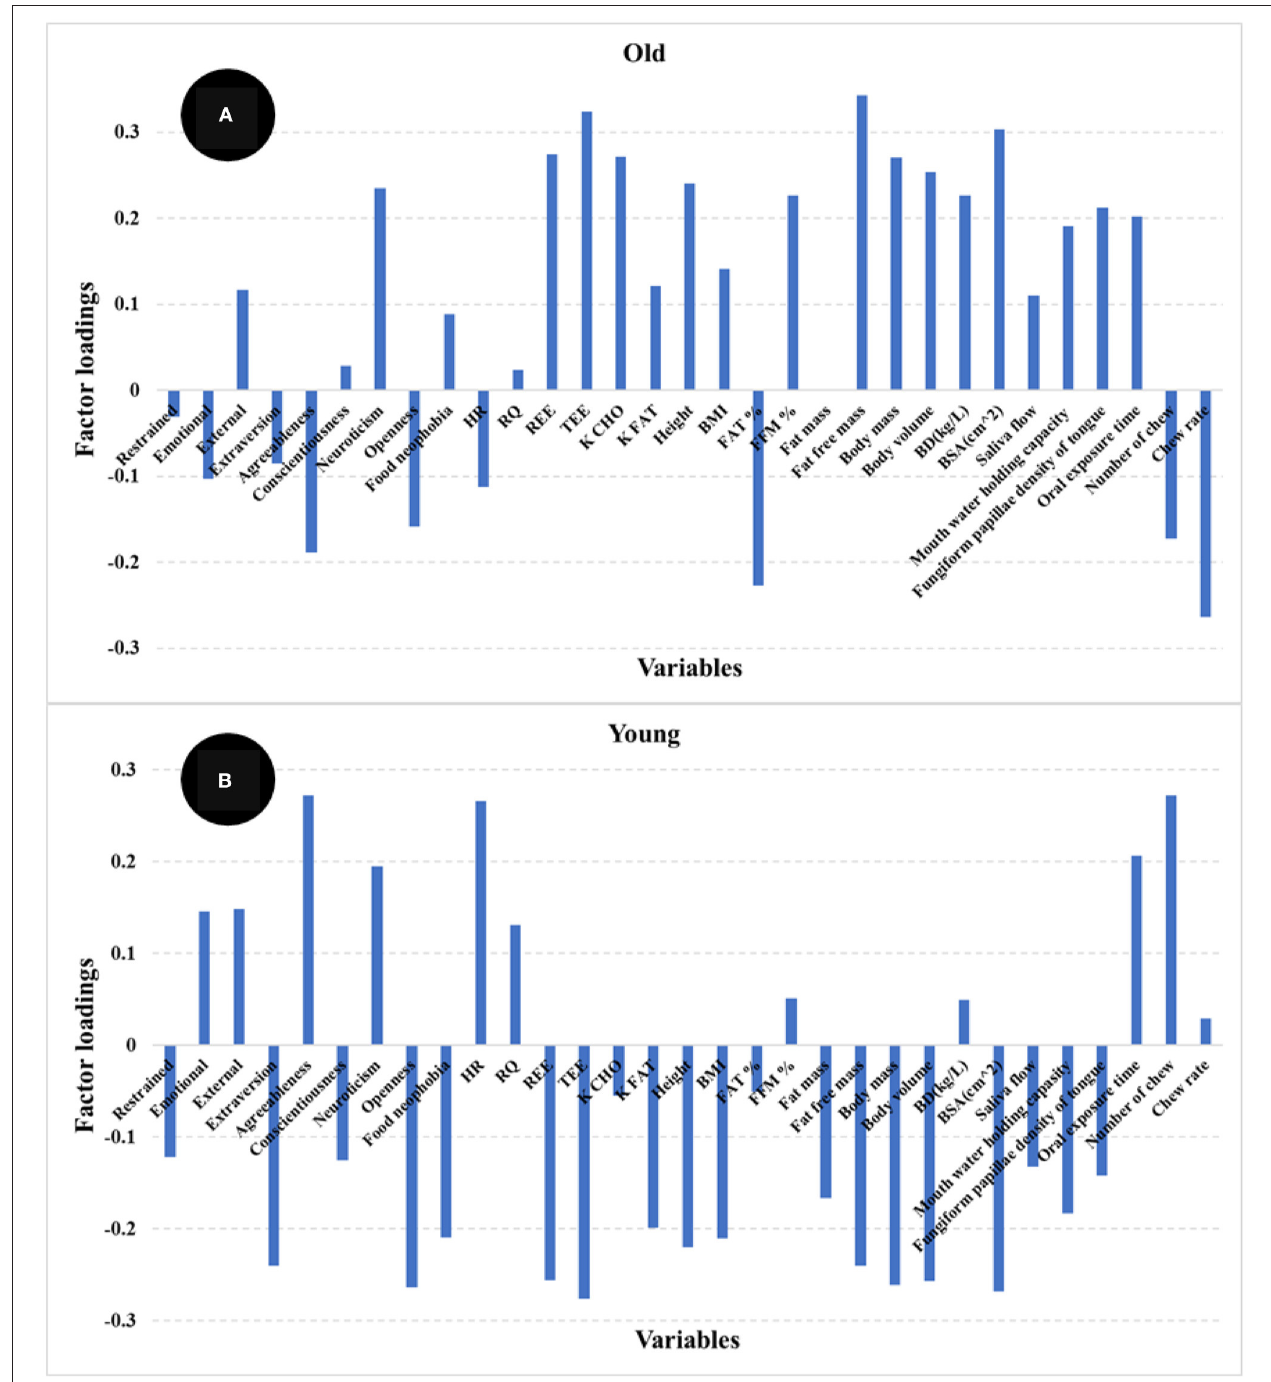
FIGURE 7 | Loadings for PLS regression models comparing older ( > 46 years) (A) and younger ( < 46 years) (B) participants.